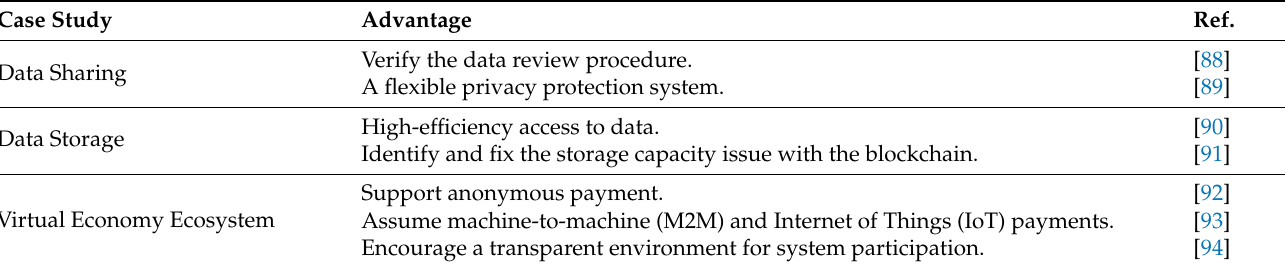
Table 3. Typical Blockchain use cases in